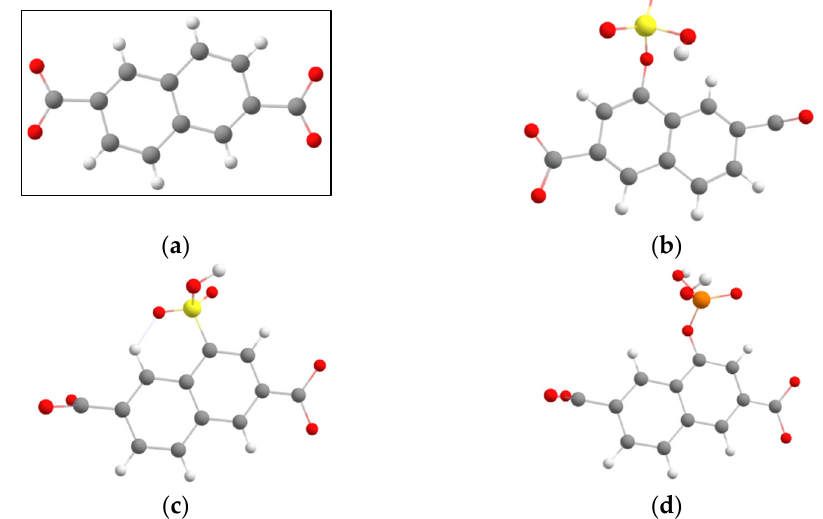
Figure 1. The original and functionalized linkers of the IRMOF-8 structures studied using GCMC simulations: ( a ) the parent IRMOF-8 linker; the ( b ) -OSO 3 H, ( c ) -SO 3 H, and ( d ) -OPO 3 H 2 functional- ized linkers. Carbon, hydrogen, oxygen, sulfur, and phosphorus atoms are depicted as gray, white, red, yellow, and orange spheres, respectively.